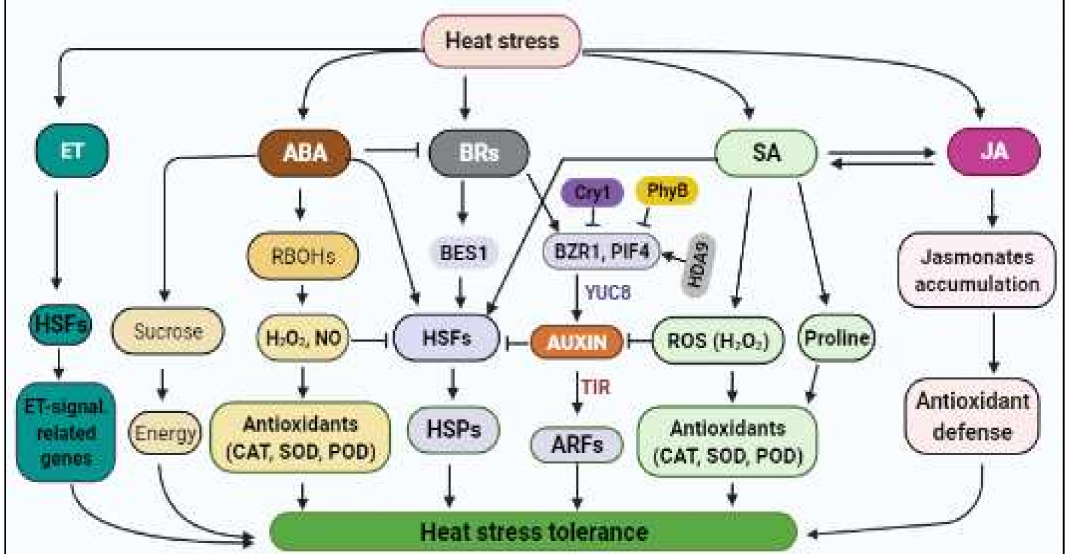
Figure 2. Phytohormonal signalling networks mediating plant HS response. The ABA signalling path- way evokes the ABA-mediated HS response through activation of downstream HSFs (e.g., HSFA6b), which then stimulate HSPs expression. The expressed HSPs invigorate photosynthesis and protein homeostasis under HS conditions, consequently leading to improved HS tolerance. Additionally, ABA mediates HS tolerance in a nitric-oxide (NO)-dependent manner, whereby the respiratory burst oxidase homologs (RBOHs), H 2 O 2 and NO-transduced HS signals regulate osmolytes accumulation and antioxidant enzyme activities. In addition, ABA modulates the levels of carbohydrates and energy status via accelerated transport and enhanced metabolism of sucrose to enhance plant HS tolerance. Meanwhile, sucrose alone may act as a regulatory signal and/or provide energy, thereby contributing to HS tolerance. However, ABA has been shown to inhibit brassinosteroids (BRs) functioning in HS response. BRs activate HSPs through BR-controlled transcription factors such as Brassinosteroid Insensitive 1 (BRI1), EMS-Suppressor 1 (BES1), Brassinazole Resistant 1 (BRZ1) and phytochrome interacting factors (PIFs, e.g., PIF4, PIF7, etc.). BES1 may also evoke the